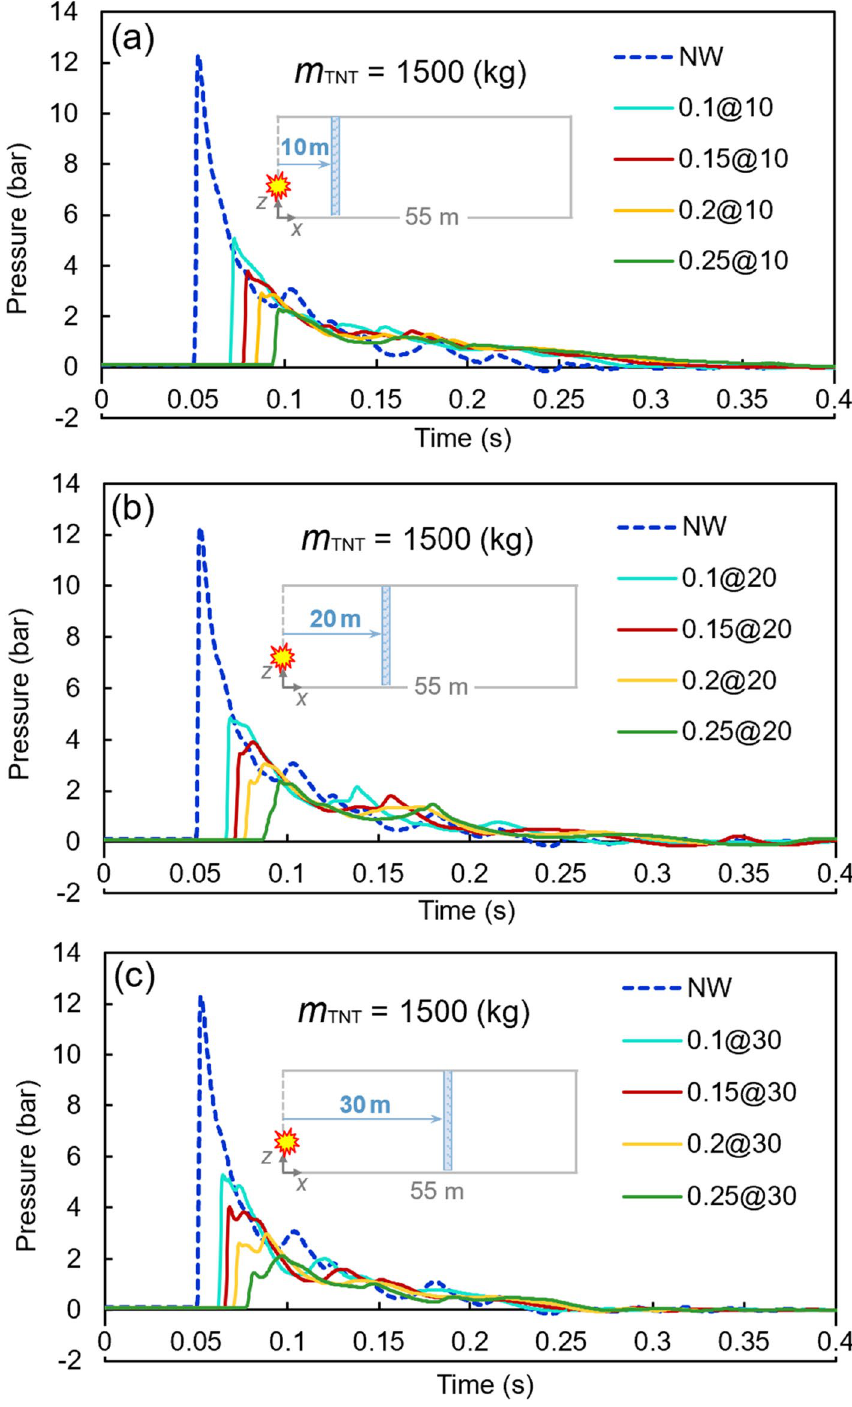
Figure 9. Pressure–time diagrams of the 1500-kg TNT charge with different water curtains at various distances: ( a ) 10 m, ( b ) 20 m, and ( c ) 30